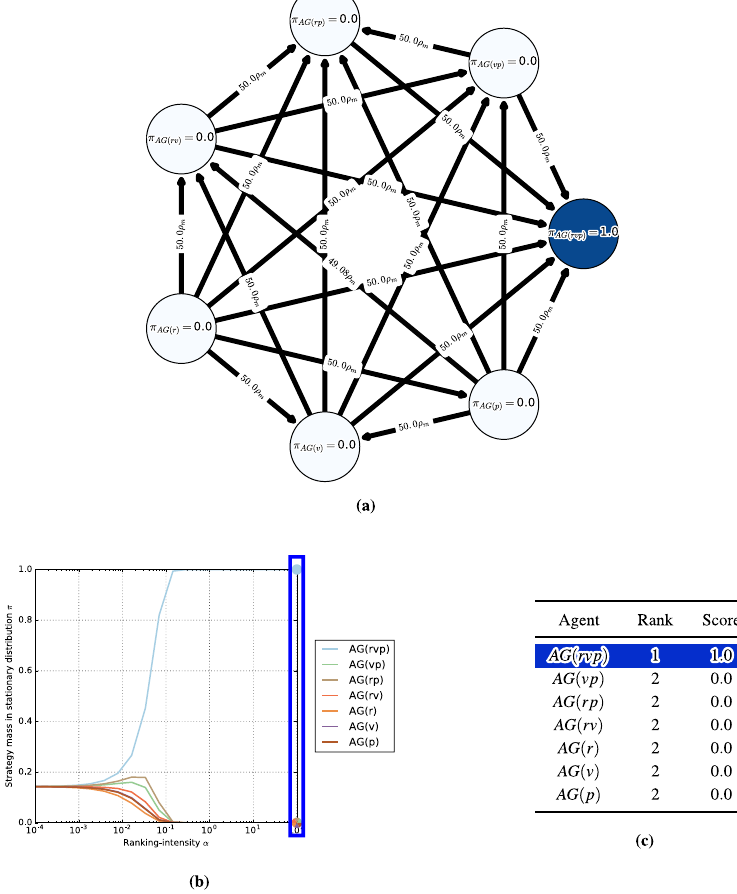
Figure 9. AlphaGo (Nature dataset). ( a ) Discrete-time dynamics. ( b ) Ranking-intensity sweep. ( c ) α -Rank